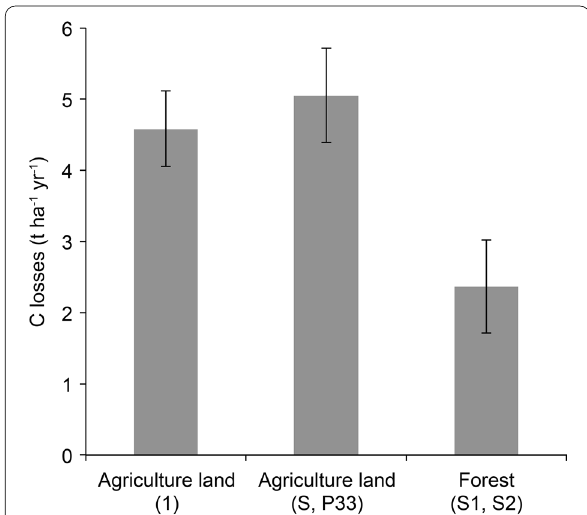
Fig. 8 Calculated total C losses from selected mires at agricultural sites and in the forest. The error bars indicate the measurements errors and variability of replicates